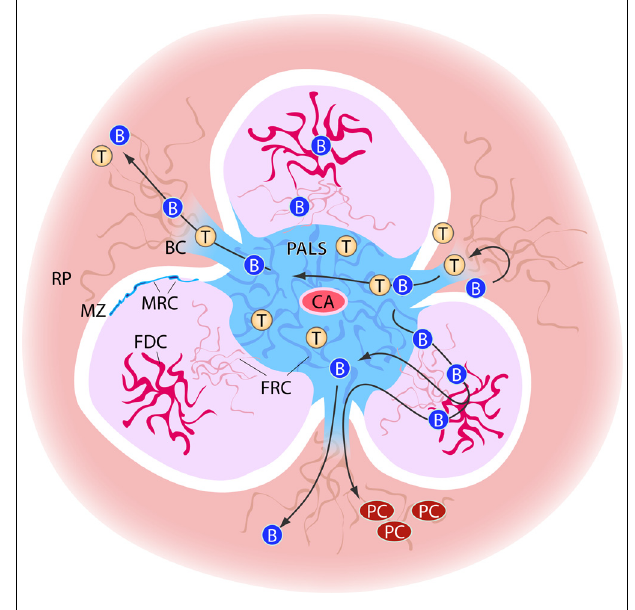
FIGURE 1 | Schematic view of stromal elements in the spleen. T and B cells enter the spleen white pulp area via from the marginal zone via bridging channels (BC). Cells first enter theT cell zone of the white pulp, the PALS (peri-arteriolar sheath) in which fibroblast reticular cells (FRC) are the predominant stromal element. In the B cell zones, the follicles, stromal cells form a less dense network and here the follicular dendritic cells (FDCs) play an important role in B cell activation. PALS and follicles are surrounded by the marginal zone (MZ). At the border of marginal zone andT and B cell zone, the marginal reticular cells (MRC) can be found.The bridging channels also form the route of exit for lymphocytes from the white pulp. B cells that have undergone differentiation and maturation in the follicles may exit the white pulp to localize as plasma cells (PC) in the red pulp